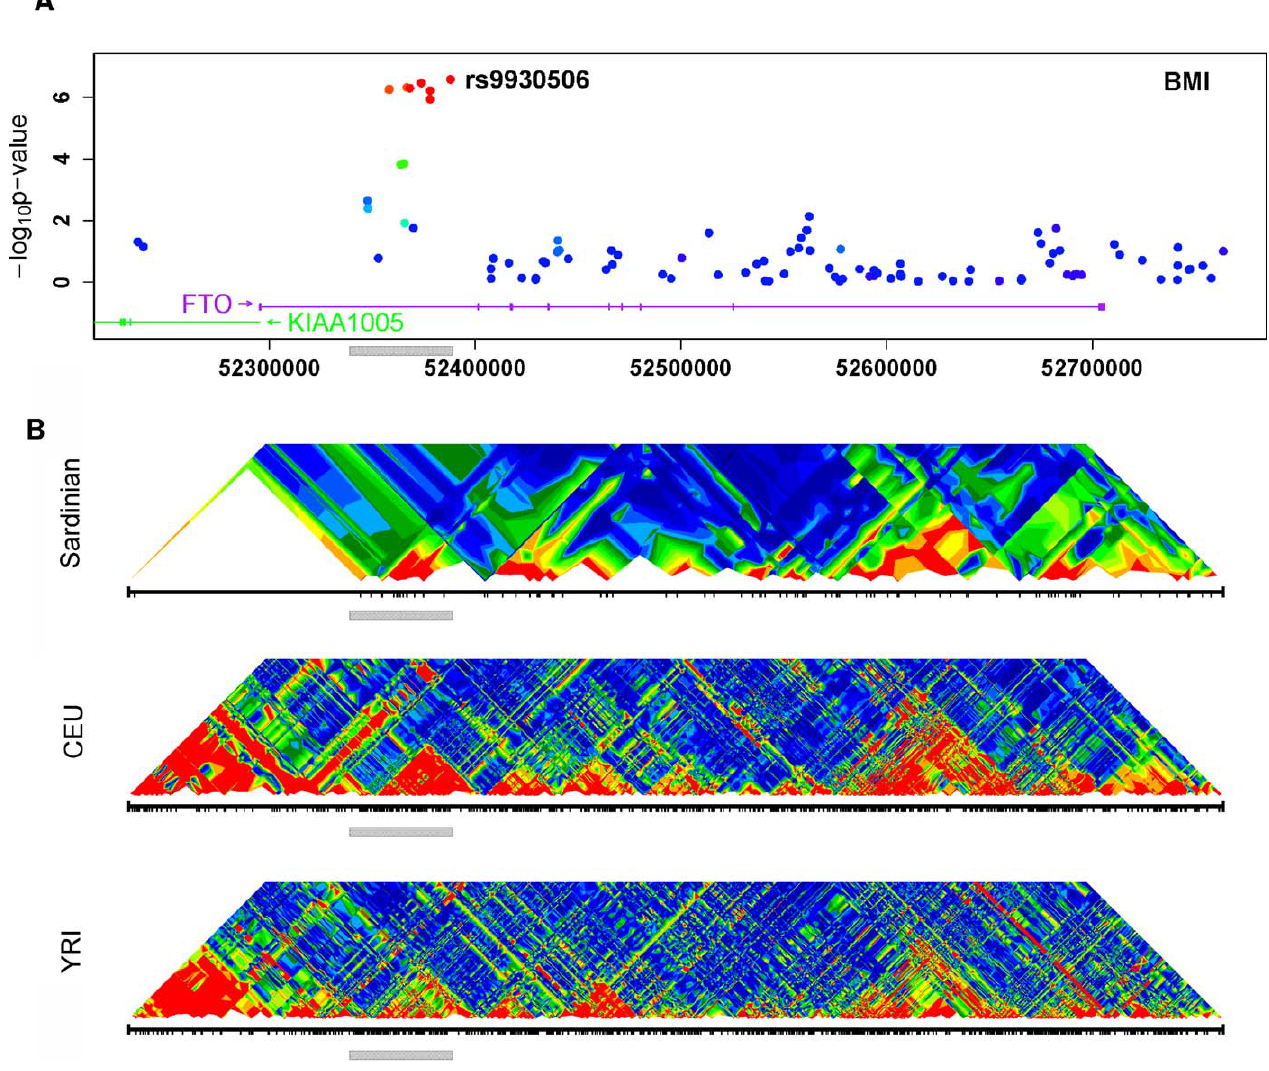
Figure 2. Association Results and LD Patterns in Region Surrounding the FTO Gene (A) Summary of the association between SNPs in the region and BMI. The SNP showing strongest association (rs9930506) is highlighted. Other SNPs are colored according to their degree of disequilibrium with rs9930506 ranging from high (red), to intermediate (green), to low (blue). Transcripts are indicated at the bottom of the graph, with an arrow indicating transcript direction. (B) Summary of the patterns of disequilibrium in the region in Sardinia and in two of the HapMap populations (CEU and YRI) [55]. The grey bar marks the region of association and facilitates comparisons between the panels.